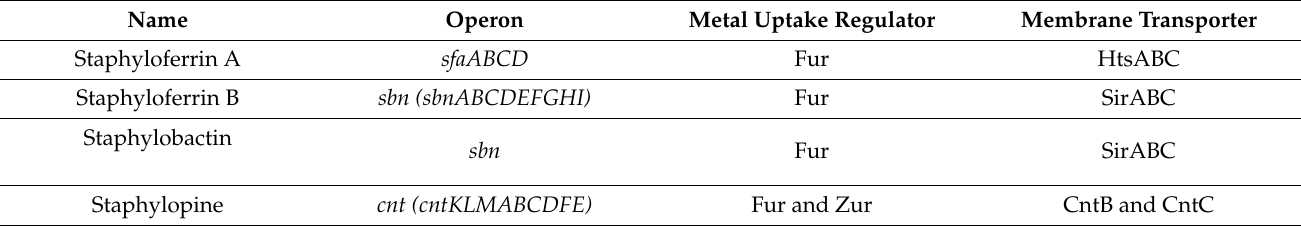
Table 2. S. aureus metallophores regulation and